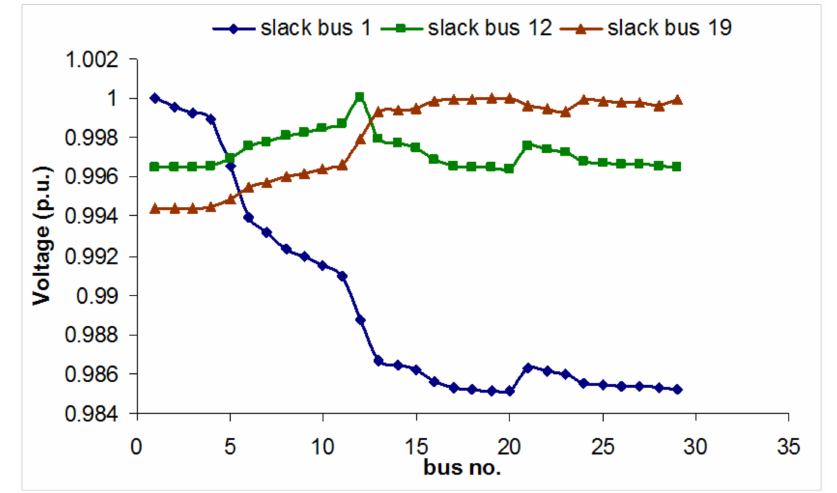
Figure 11. Variation of voltage profile with location of PV system for a load of 1 kW.